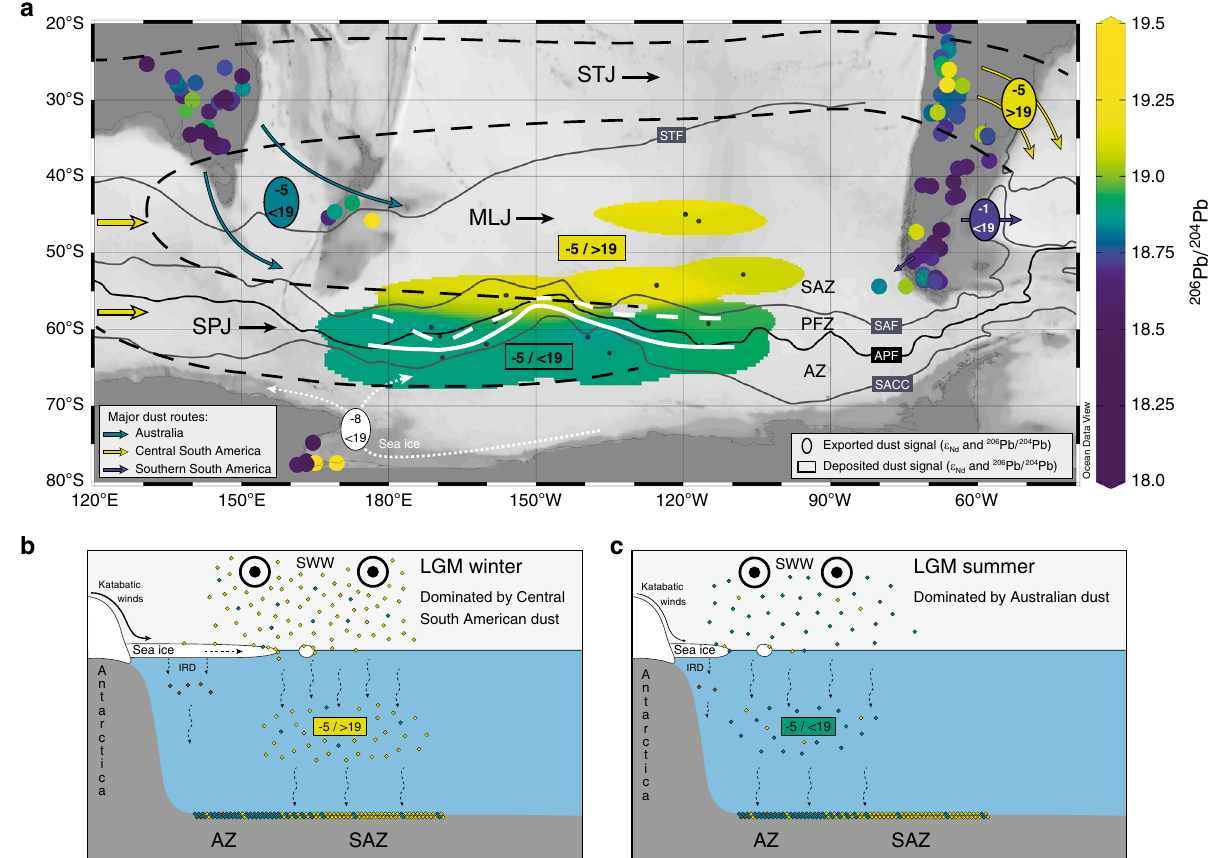
Fig. 5 The transport and deposition of dust in the South Paci fi c during the Last Glacial Maximum. a The distribution of dust fraction 206 Pb/ 204 Pb in the glacial South Paci fi c. Solid and dashed white lines delineate the limits of 40% and 15% winter sea-ice cover during the Last Glacial Maximum (LGM) 77 , respectively. Black dots: LGM time slice sampling locations. The dashed black outline indicates the modern zones of increased wintertime wind speed maxima in the high-altitude (200 hPa) westerly wind fl ow of the subtropical (STJ) and subpolar (SPJ) branches of the jet stream located north and south of the reduced mid-latitude jet (MLJ), respectively 73 . Terrestrial source data from the literature listed in Supplementary Table 3. It is noteworthy that some original terrestrial sample coordinates were slightly modi fi ed to improve visibility in this fi gure. Ocean fronts from ref. 94 . STF: Subtropical Front. SAF: Subantarctic Front. APF: Antarctic Polar Front. SACC: Southern ACC Front. SAZ: Subantarctic Zone. PFZ: Polar Frontal Zone. AZ: Antarctic Zone. Map created with Ocean Data View software 95 . b The LGM wintertime scenario. The northward expanded Southern Hemisphere westerly wind (SWW) system (STJ present in the South Paci fi c as in a ) delivers dust ef fi ciently on a circumpolar trajectory from Central South America to the study area. The extensive sea-ice cover reduces the dust deposition in the South Paci fi c AZ. IRD: ice-rafted detritus. Numbers in yellow box as in a . c The LGM summertime scenario. The STJ transporting dust from Central South America is absent, the SWW move closer to Antarctica and deliver predominantly Australian dust to